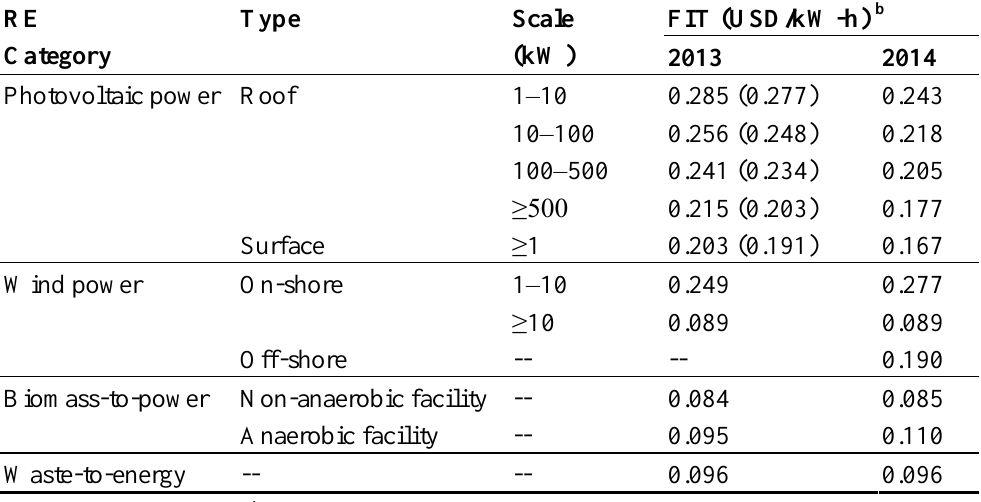
Table 1. Feed-in tariff (FIT) for renewable energy (RE) production in Taiwan a